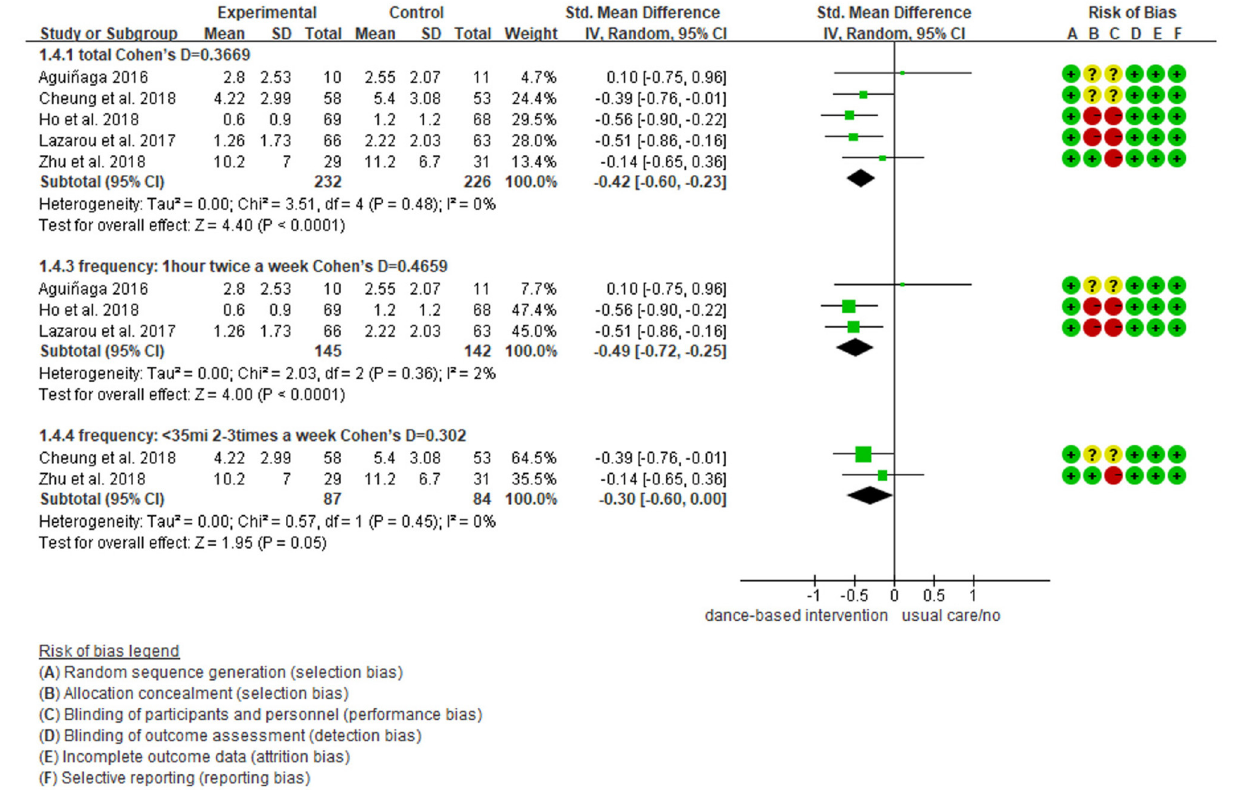
FIGURE 6 | Subgroup analyses of the intervention group vs. the control group on depression rating scores: Intervention